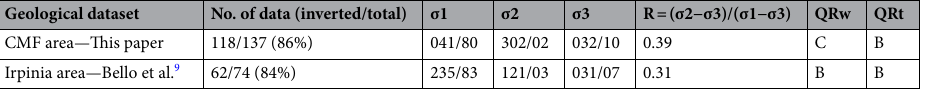
Table 3. Stress inversion parameters σ1, σ2, σ3 (trend/plunge) and R as computed in the inversion procedure of the geological datasets from this paper and from Bello et al. 9 for the Irpinia earthquake epicentral